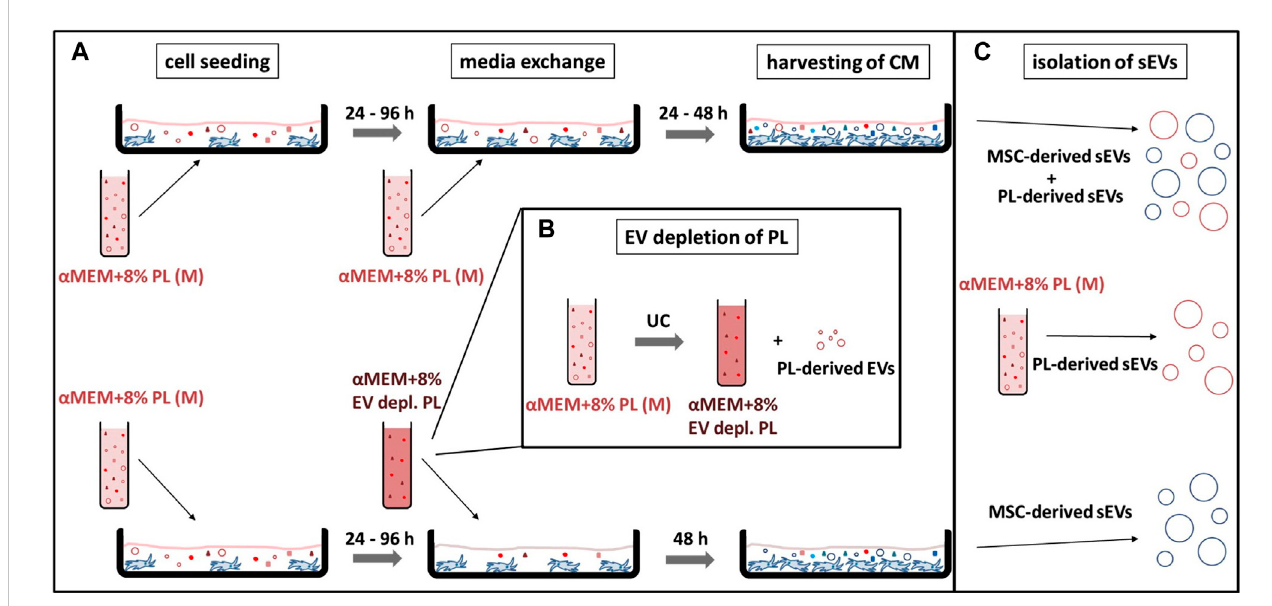
Work fl ow of different sEV collection strategies. (A) MSCs were seeded at 2,000 – 4,000 cells/cm 2 in the media α MEM+8% PL (M) and expanded for P1 or P2. After 24 – 96 h media was exchanged completely for the collection of sEVs in CM. In addition to α MEM+8% PL, α MEM+8% EV depl. PL was chosen as collection media for enrichment of MSC-derived sEVs. In order to exclude an impact of batch-to-batch variation of PL, the same starting batches of PL (from thesamedonors)wereusedfortheexperimentsshownintheupperandlowerrow,whichjustdifferedwhetherornotEVdepletionhasbeenperformed. Collection time was set to 24 or 48 h for α MEM+8% PL cultures and to 48 h for α MEM+8% EV depl. PL cultures. CM was harvested and stored at − 80 ° C until isolation of sEVs. (B) α MEM+8% EVdepl. PL was manufactured by UC of PL for 3 hat 120,000× g at 4 ° C, whereby the pellet containing the PL-derived EV was withdrawn. (C) sEVs isolated from CM collected with α MEM+8% PL included MSC-derived and PL-derived sEVs, whereas sEVs collected with α MEM+8% EV depl. PL solely included MSC-derived sEVs. PL-derived sEVs were isolated from the media α MEM+8% PL to con fi rm the